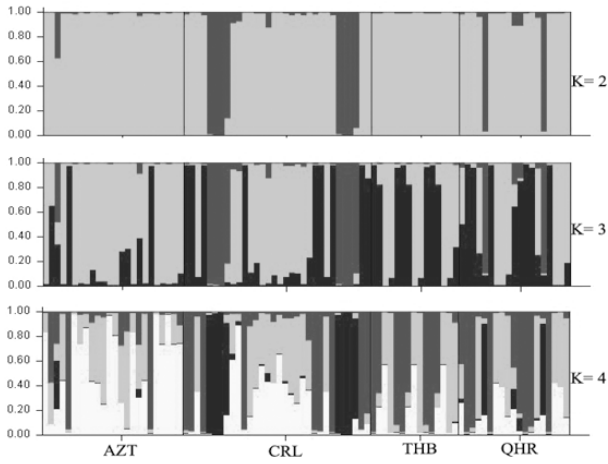
Figure 1. Population structure graphics showing K 2 to K 4 cluster- ing of four horse breeds in South-Central